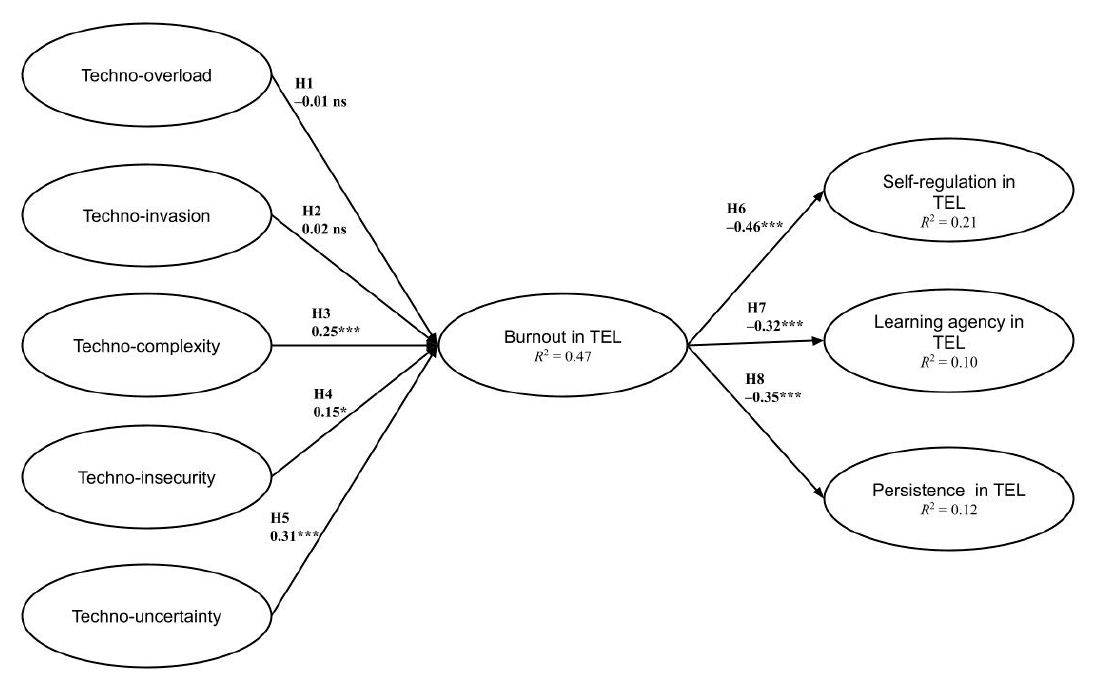
Figure 2. Validated SSO model of technostress. Note. * p < 0.05; *** p < 0.001; ns = non-significant.